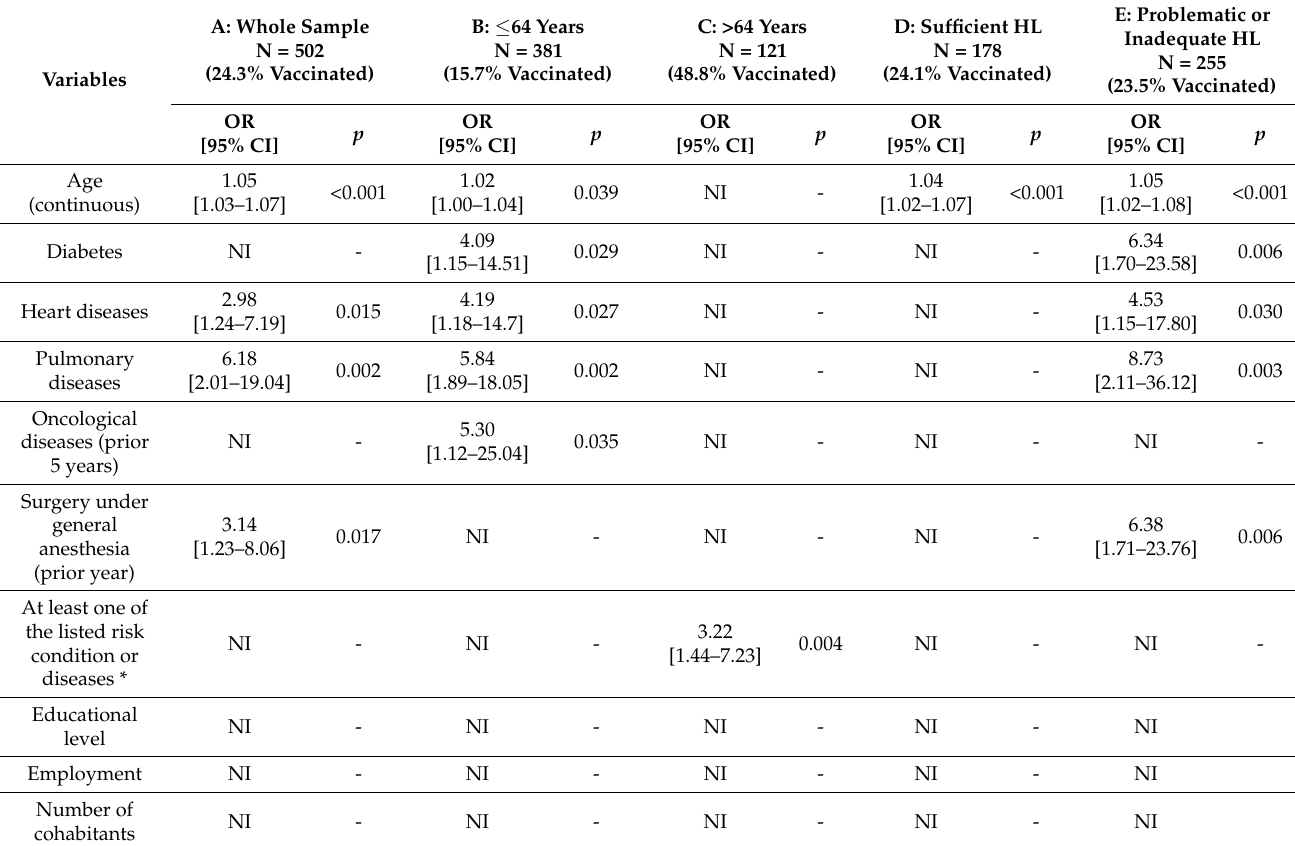
Table 3. Multivariate logistic regression final models for predicting vaccination uptake in the 2019–2020 season (odds ratio of having taken the vaccine). A: whole sample; B: people ≤ 64 years old; C: people >64 years old; D: people with sufficient health literacy (HL) according to HLS-EU-Q6; E: peo- ple with problematic or inadequate health literacy (HL) according to HLS-EU-Q6. NI = not